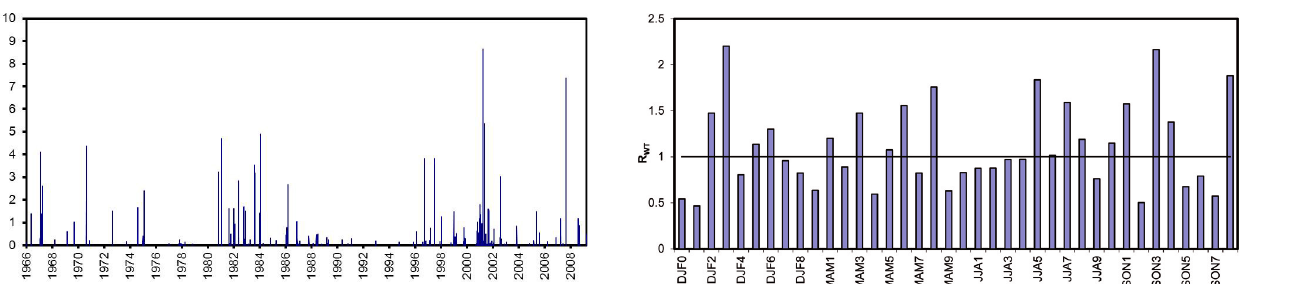
ratio for each weather type compared to the average seasonal flow. Note: R WT =1 corresponds to the average seasonal Dhuy river flow for the considered